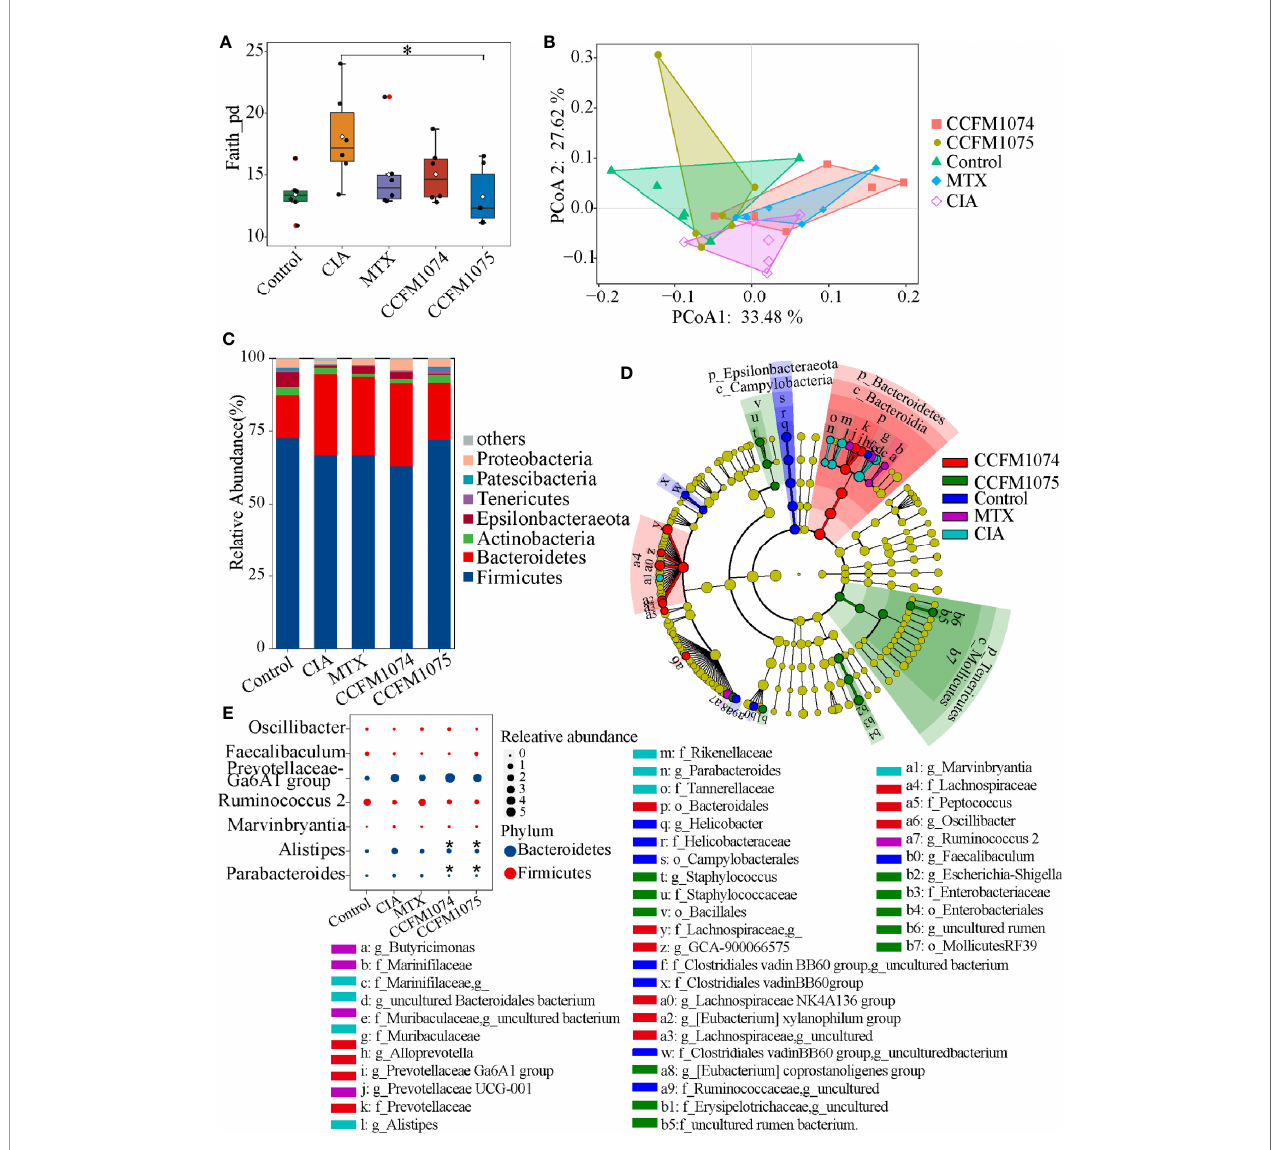
FIGURE 3 | Effects of L. casei on gut microbiota in CIA rats. The effects of L. casei on alpha diversity of Faith_pd (A) and PCoA of beta diversity (B) after L. casei treatment. The gut microbial compositions pro fi les at the phylum level (C) . The differential microbial taxa among groups were shown as cladogram by LEfSe analyze (D) . Changes of the relative abundance at the genus level (E) . control (vehicle-treated with saline 1.5 mL/day) group, CIA (vehicle-treated with saline 1.5 mL/day) group, methotrexate (MTX)-treated (6 mg/kg/week) group, CCFM1074 (treated with CCFM1074, 8.5 × 10 9 CFU/day) group and CCFM1075 (treated with CCFM1075, 8.5 × 10 9 CFU/day) group, eight rats per group. * p < 0.05 (Kruskal-Wallis test with Dunn ’ s multiple comparisons test). *, vs.